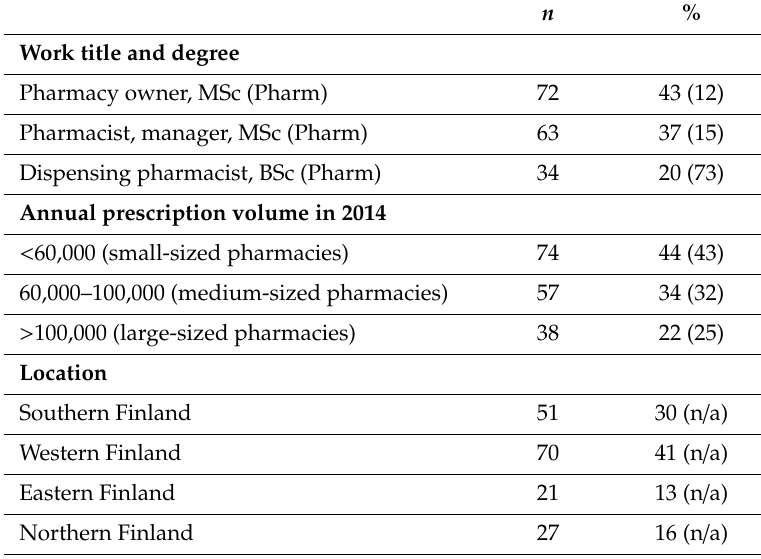
Table 1. Characteristics of the respondents and their community pharmacies ( n = 169). The percentages in brackets describe the situation of all pharmacies in Finland ( n = 574). Data source: The Association of Finnish